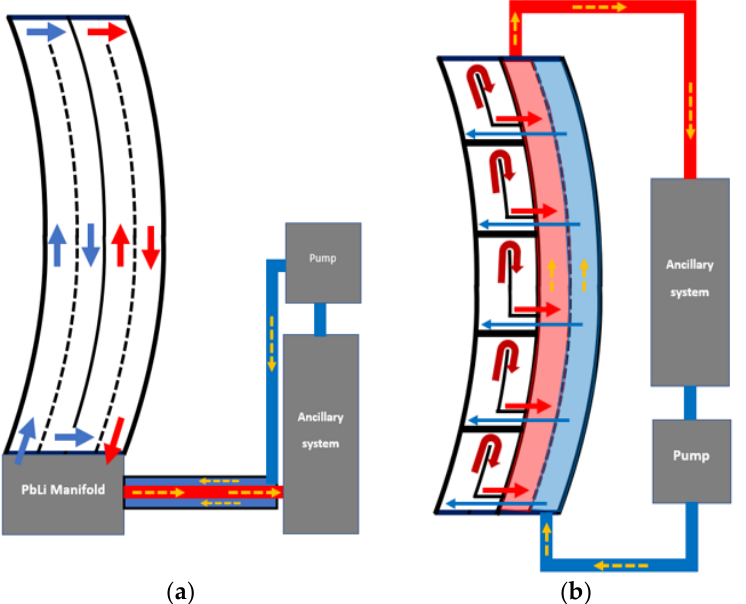
Figure 4. Two possible designs of the DCLL blanket. ( a ) full segment “banana” blanket; and ( b ) modular blanket.